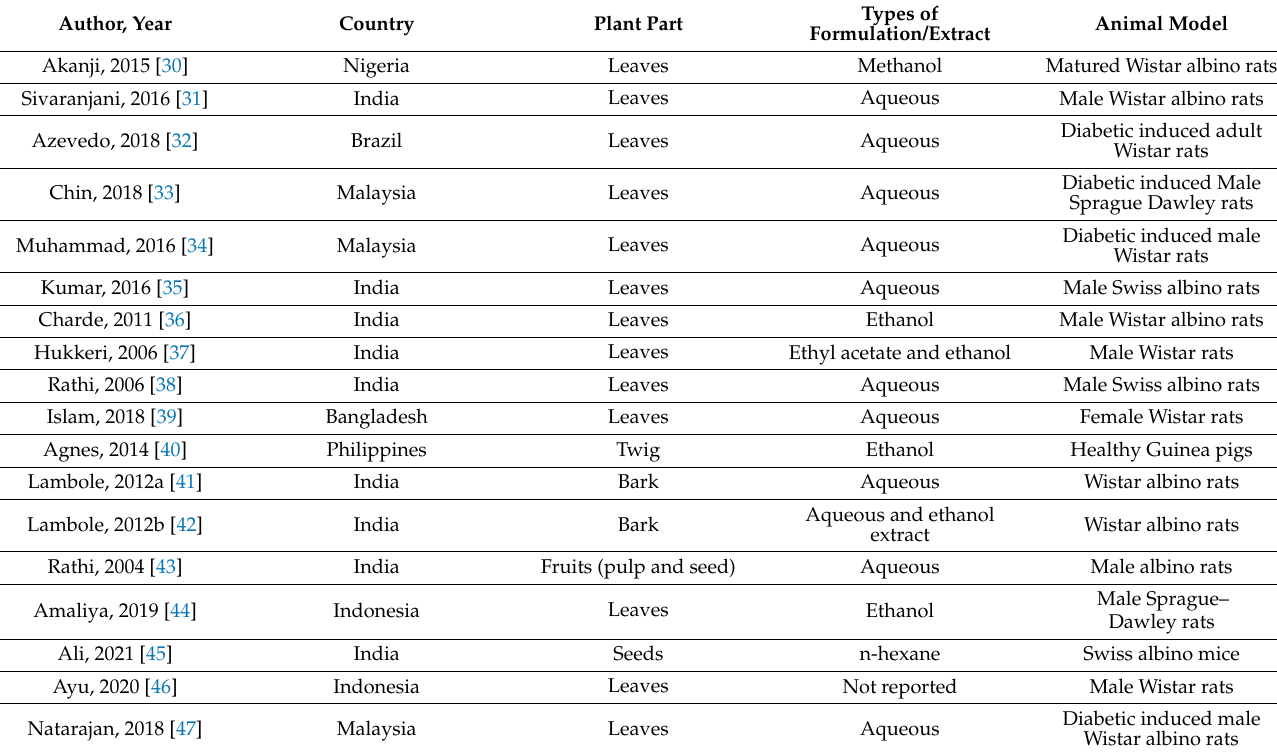
Table 1. Characteristics of included studies.